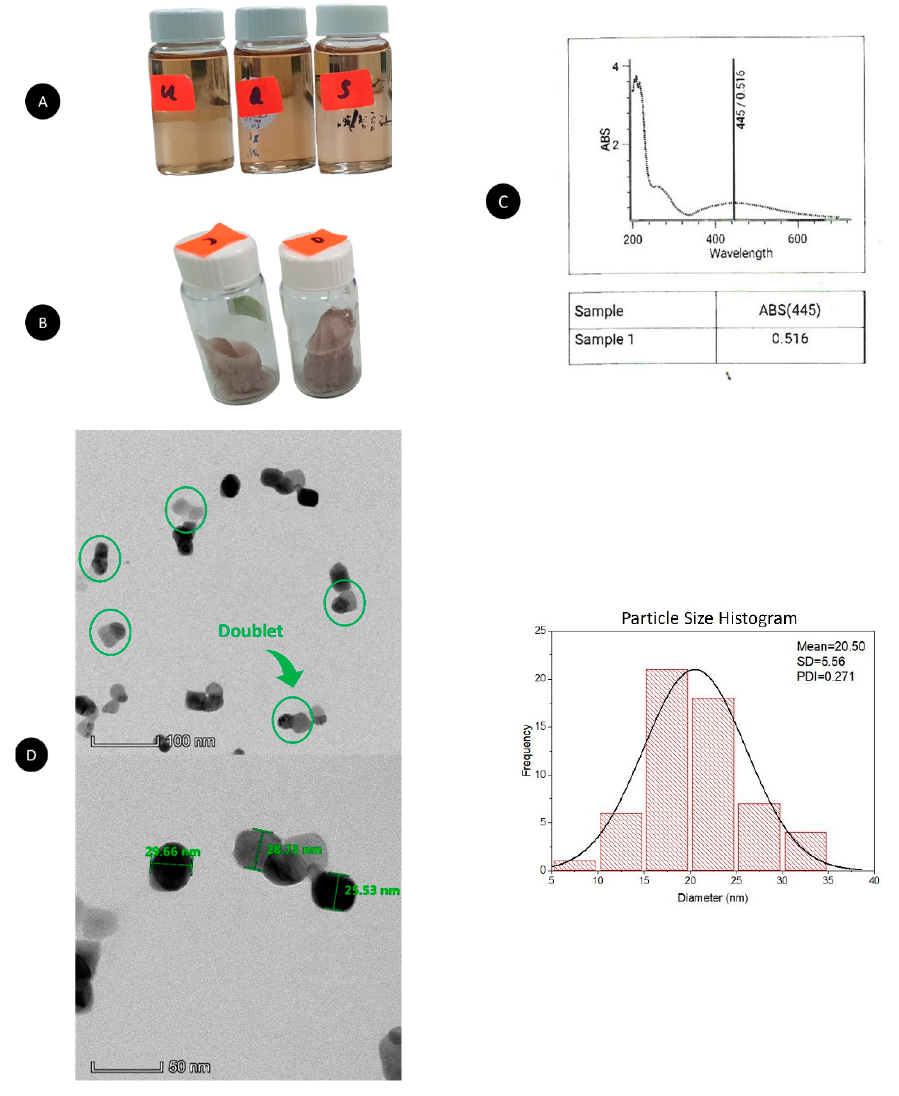
Figure 1. ( A ) Color changes in the reaction mixture of AgLTF, ( B ) Physical appearance of lyophilized AgLTF, ( C ) UV-vis spectrophotometry of AgLTF, and ( D ) TEM micrograph of AgLTF at 260 kx (top) and 600 kx (bottom) and its corresponding particle size distribution.